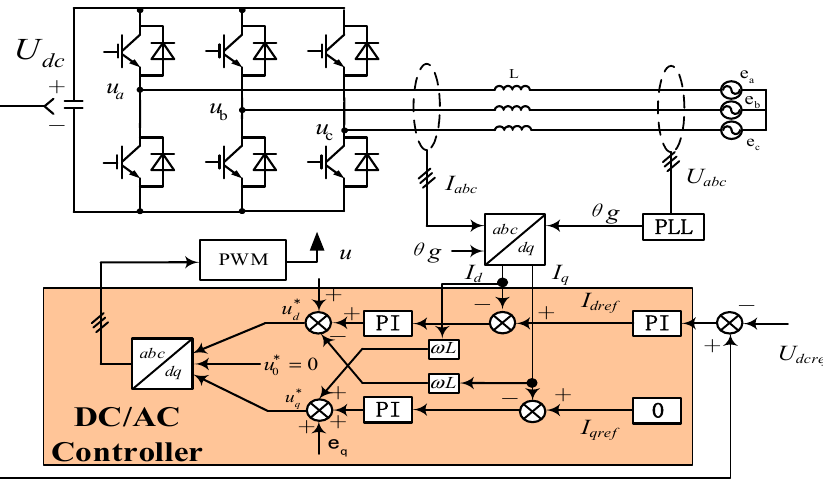
Figure 9. Control strategy of the DC/AC inverter.